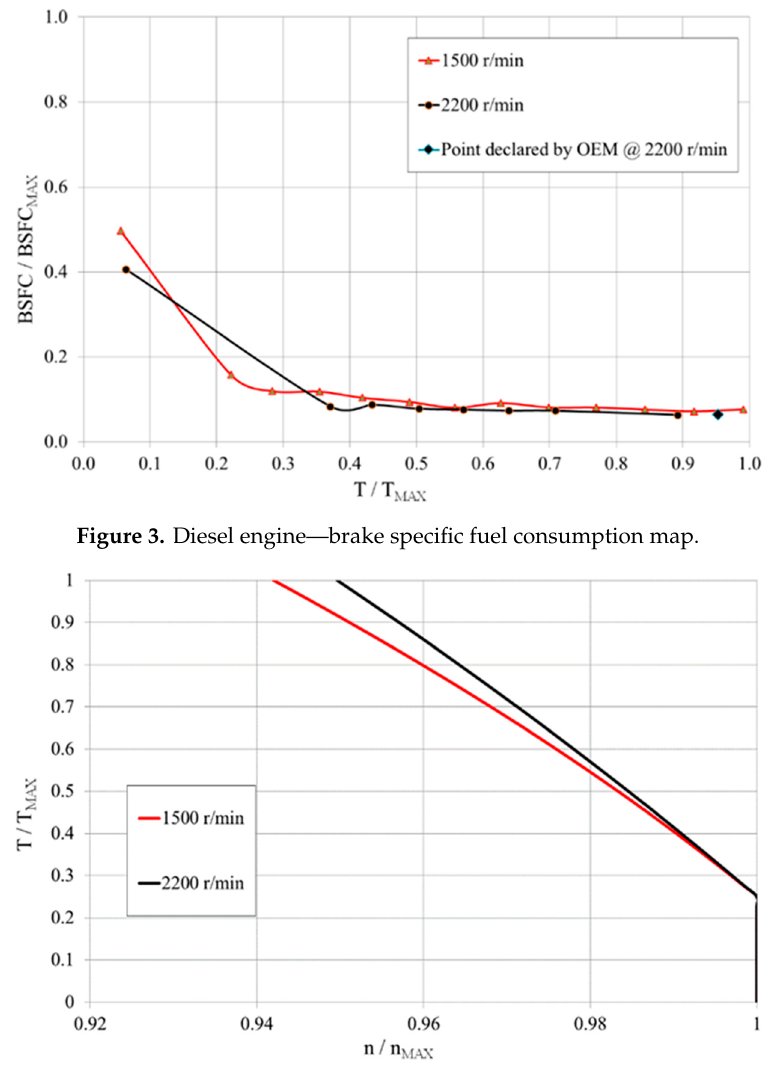
Figure 4. Diesel engine—shaft speed variation with torque.